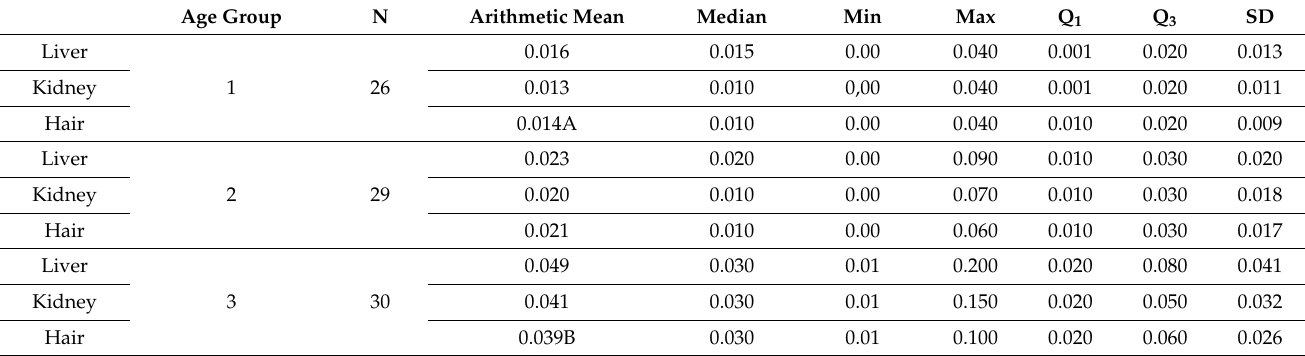
Table 5. Mercury contents depending on cat age in milligrams per